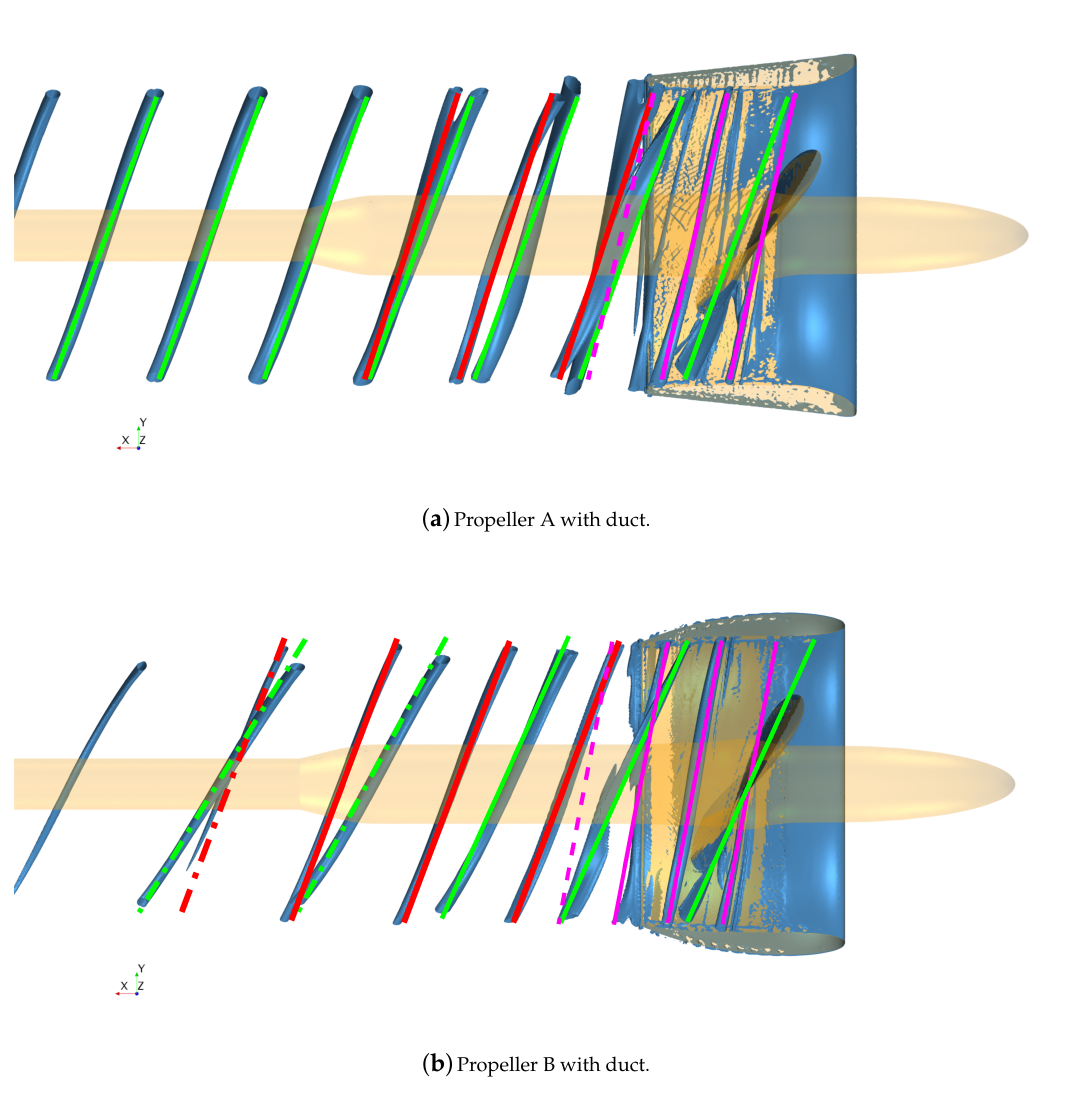
Figure 19. Qualitative analyses of the vortex structures generated by the ducted